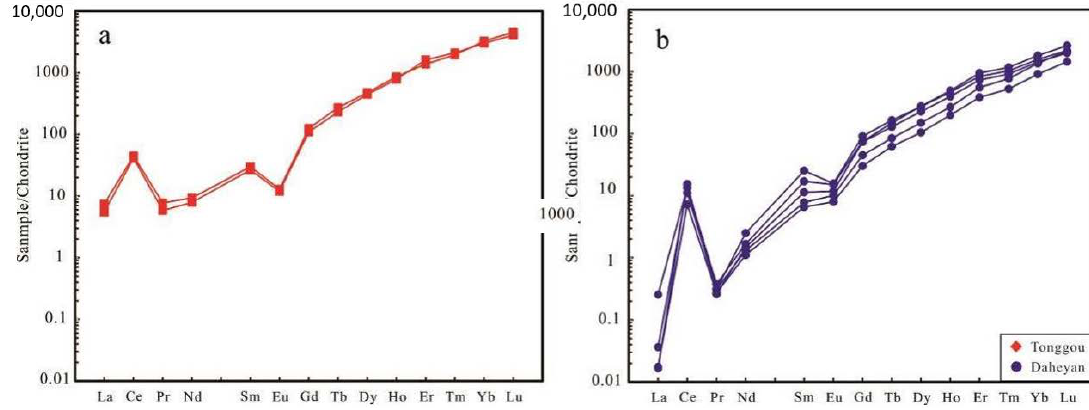
Figure 8. (a) Chondrite-normalized REE pattern diagram from zircon for Tonggou mineralized Figure 8. ( a ) Chondrite-normalized REE pattern diagram from zircon for Tonggou mineralized granodiorite samples; (b) chondrite-normalized REE pattern diagram from zircon for Daheyan granodiorite samples; ( b ) chondrite-normalized REE pattern diagram from zircon for Daheyan barren barren granodiorite samples [ 67 ]. granodiorite samples